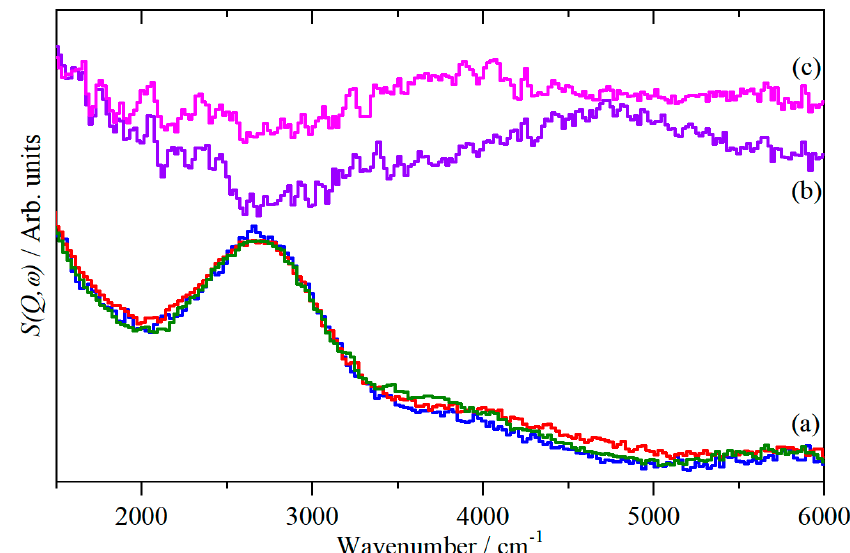
Figure 6. INS spectra at 7 K in the high energy region ( E i = 16,000 cm − 1 ) of ( a ) clean Fe-BTC (blue), Fe-BTC + H 2 (red) and Fe-BTC + HD (olive) (spectra integrated over the range 0 ≤ Q ≤ 8 Å − 1 ), ( b ) difference spectrum ((Fe-BTC + H 2 )-(clean Fe-BTC)) and ( c ) difference spectrum ((Fe-BTC + HD)-(clean Fe-BTC)) (spectra integrated over the range 5 ≤ Q ≤ 10 Å − 1 ). ( b , c ) are ordinate expanded × 2 relative to ( a ).